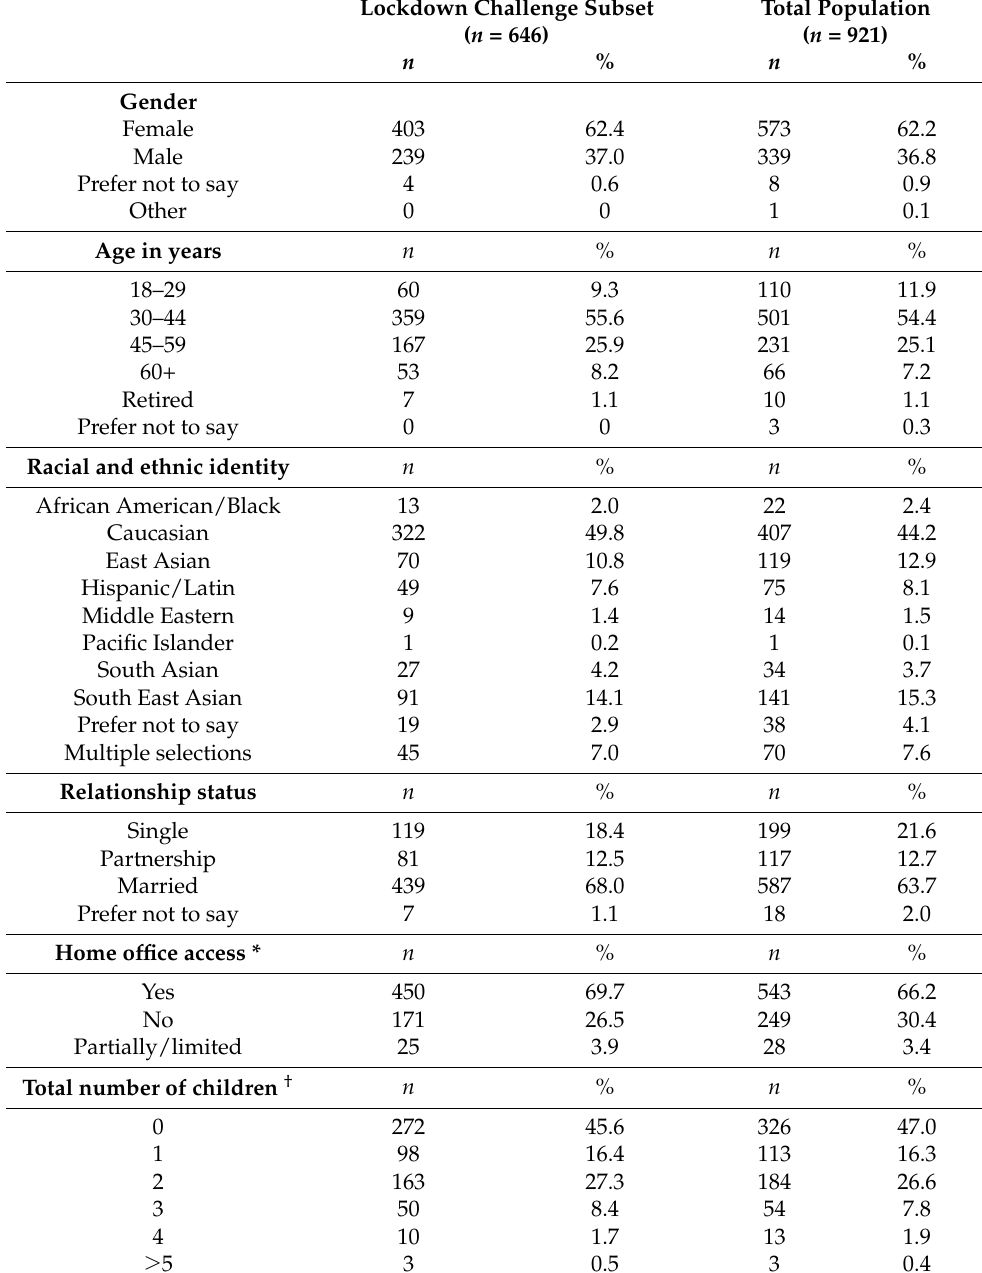
Table 1. Demographic characteristics of survey